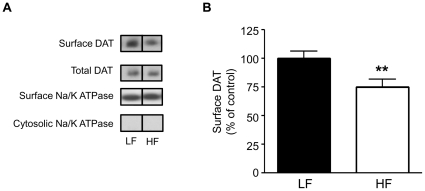
DAT cell surface expression is reduced in the striatum of HF DIO rats.(A) Representative immunoblots of biotinylated (surface) and total DAT proteins from LF and HF rats. The Na/K ATPase was used as a plasma membrane/loading control. (B) Quantification of DAT immunoreactivity. DAT surface levels were normalized to the total amount of DAT and expressed as a percent of LF control. (LF, n = 4; HF, n = 5; **p<0.01 by Students t-test,). Data are represented as mean ± S.E.M.